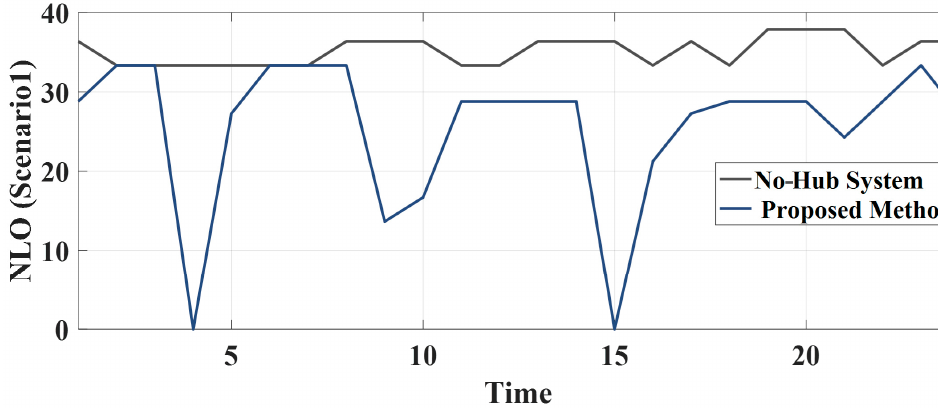
Figure 6. The vulnerability index NLO for scenario 1.